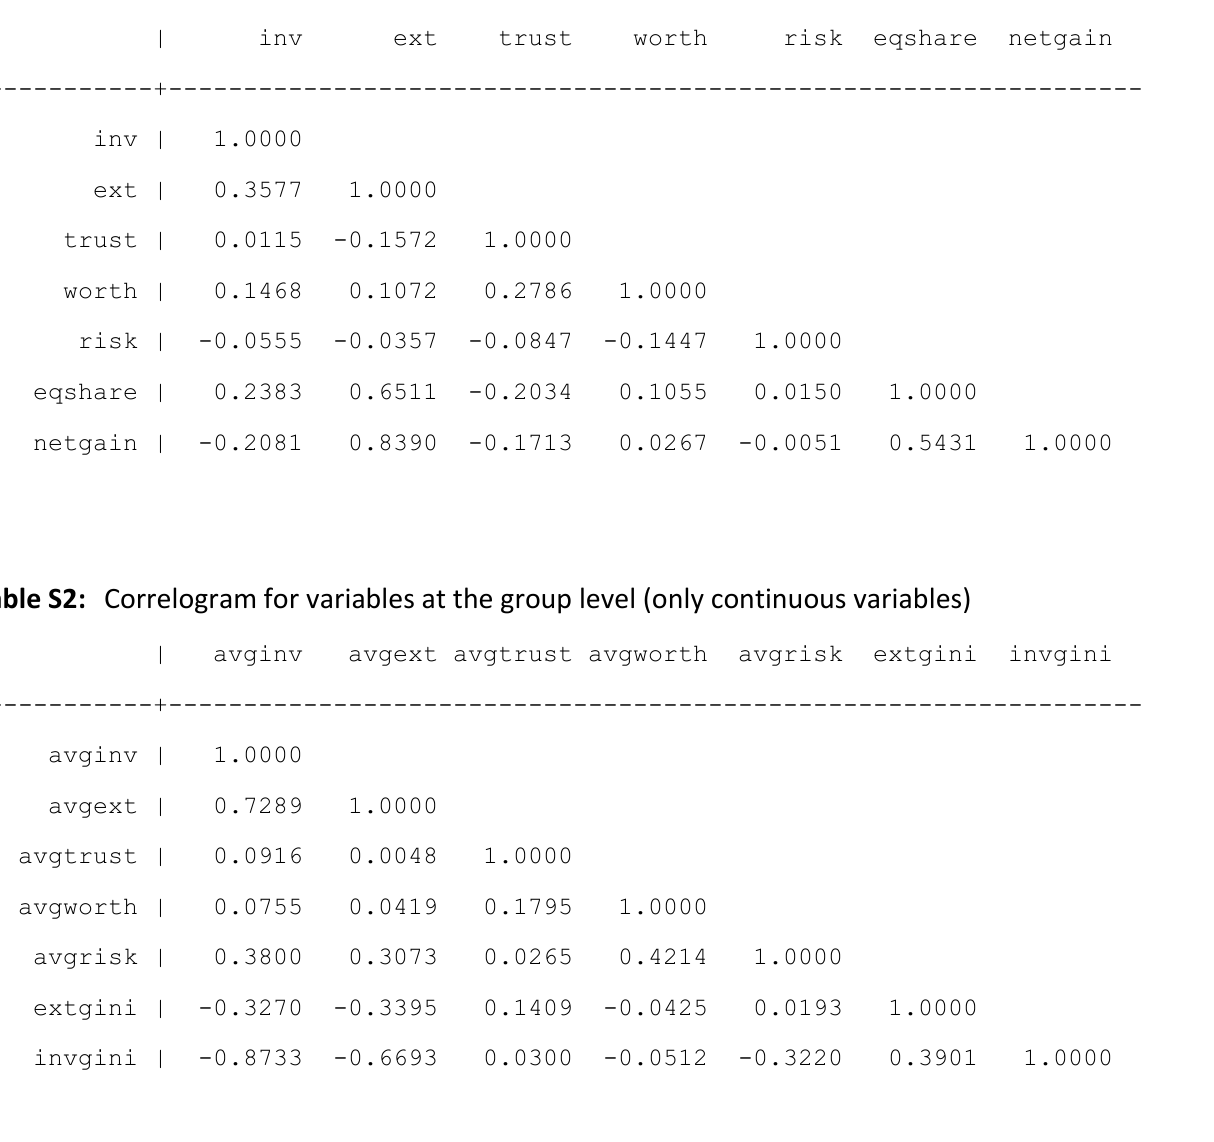
Table S1: Correlogram for variables at the individual level (only continuous variables) | inv ext trust worth risk eqshare